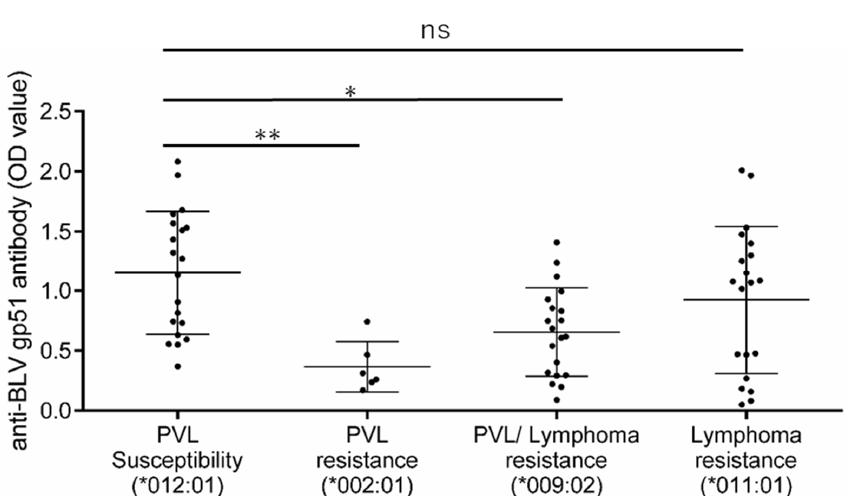
Figure 7. Differential anti-BLV antibody production level in cows with proviral load (PVL) susceptibility, PVL resistance, PVL / lymphoma resistance, and lymphoma-resistance BoLA-DRB3 allele. The PVL susceptibility group consisted of cows with the PVL susceptibility allele DRB3*012:01 ( n = 20). The PVL resistance group consisted of cows with the PVL resistance allele DRB3*002:01 ( n = 6). The PVL / lymphoma resistance group consisted of cows with the PVL resistance allele DRB3*009:02 ( n = 20). The lymphoma resistance group consisted of the lymphoma resistance allele *011:01 ( n = 20). The anti-BLV gp51 antibody was measured in plasma at a 2 11 dilution level. Optical Density (OD) value data represent the mean ± SD. Statistical comparisons were performed by one-way ANOVA. *, p < 0.05. **, p < 0.01. ns, not significant.